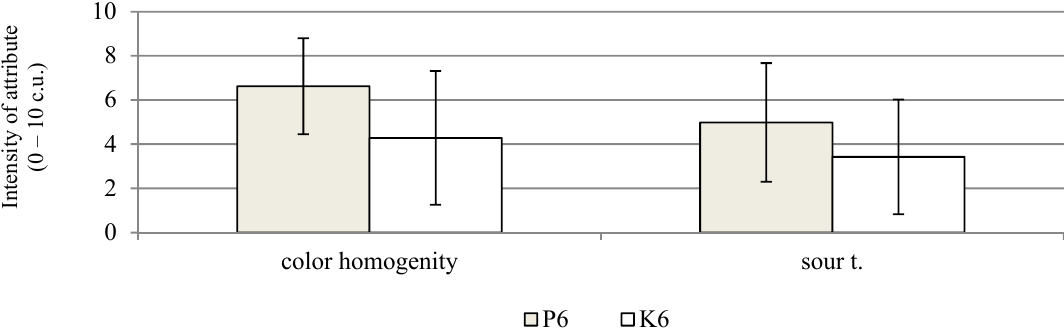
Figure 3. Significant differences in sensory attributes between dry fermented sausages with (P6) and without (K6) L. rhamnosus LOCK900 addition after 6 weeks of storage; ( α ≤ 0.05); abbreviations as at Figure 1.